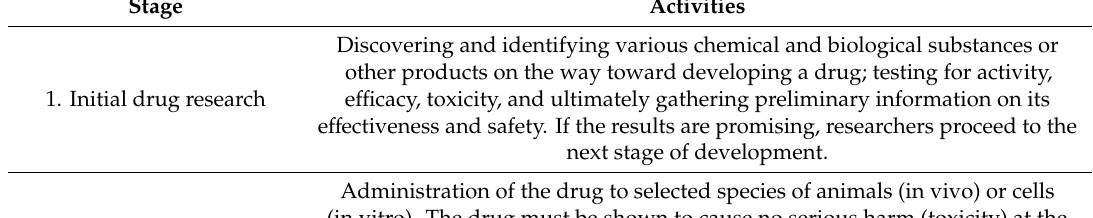
Table 2. The general drug review and approval process steps. DDIs, drug–drug